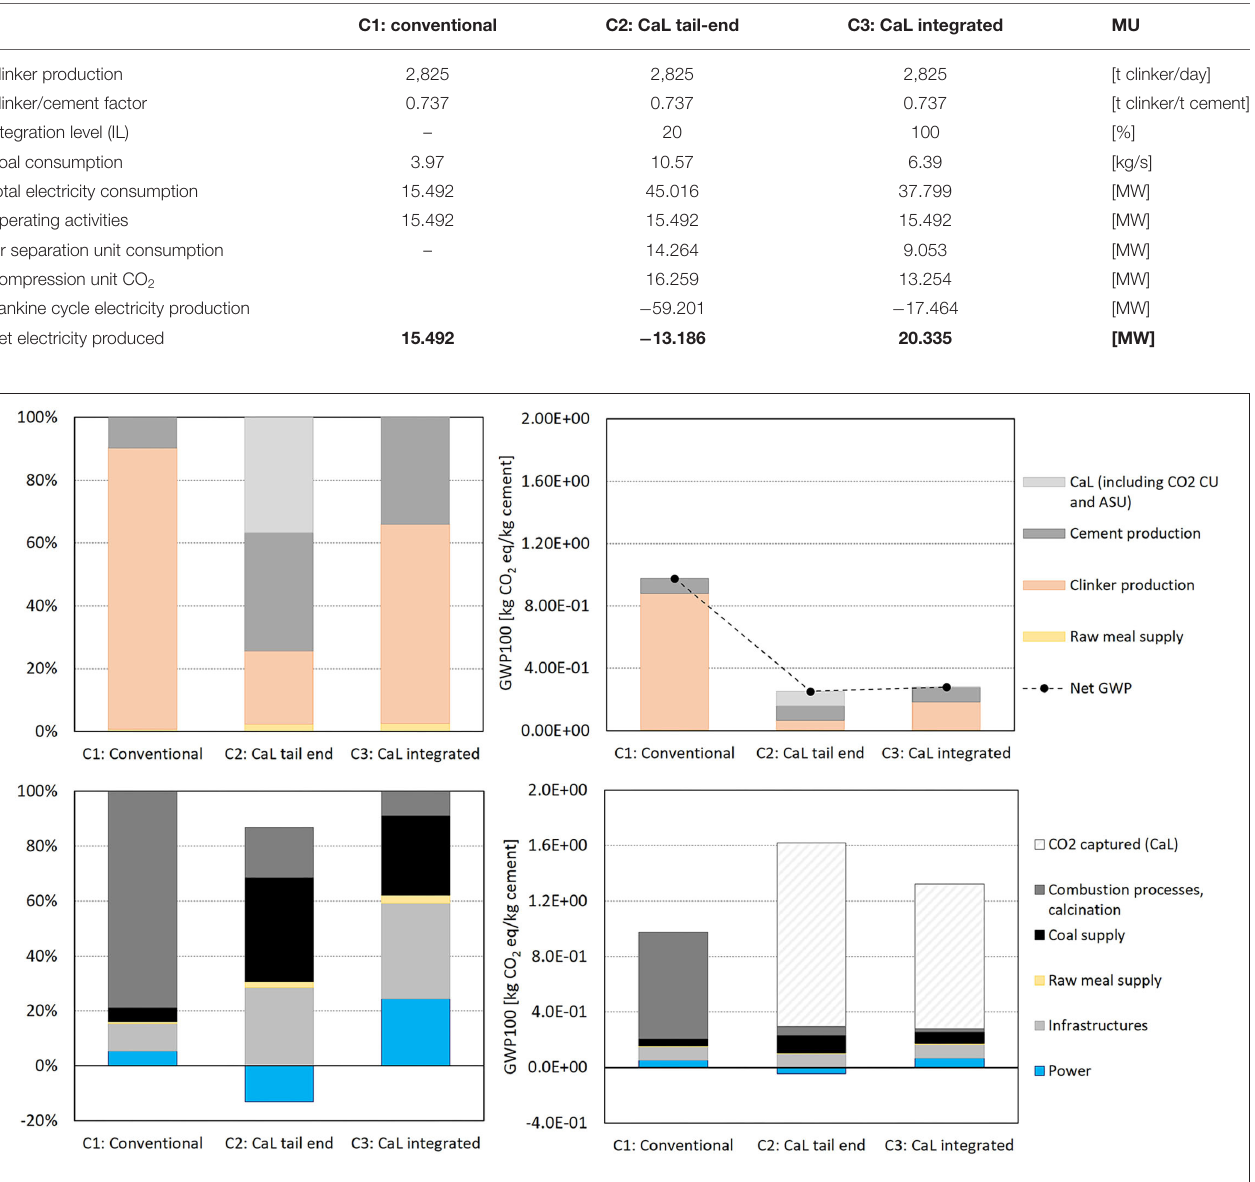
TABLE 2 | Key process parameters of the three modeled systems.